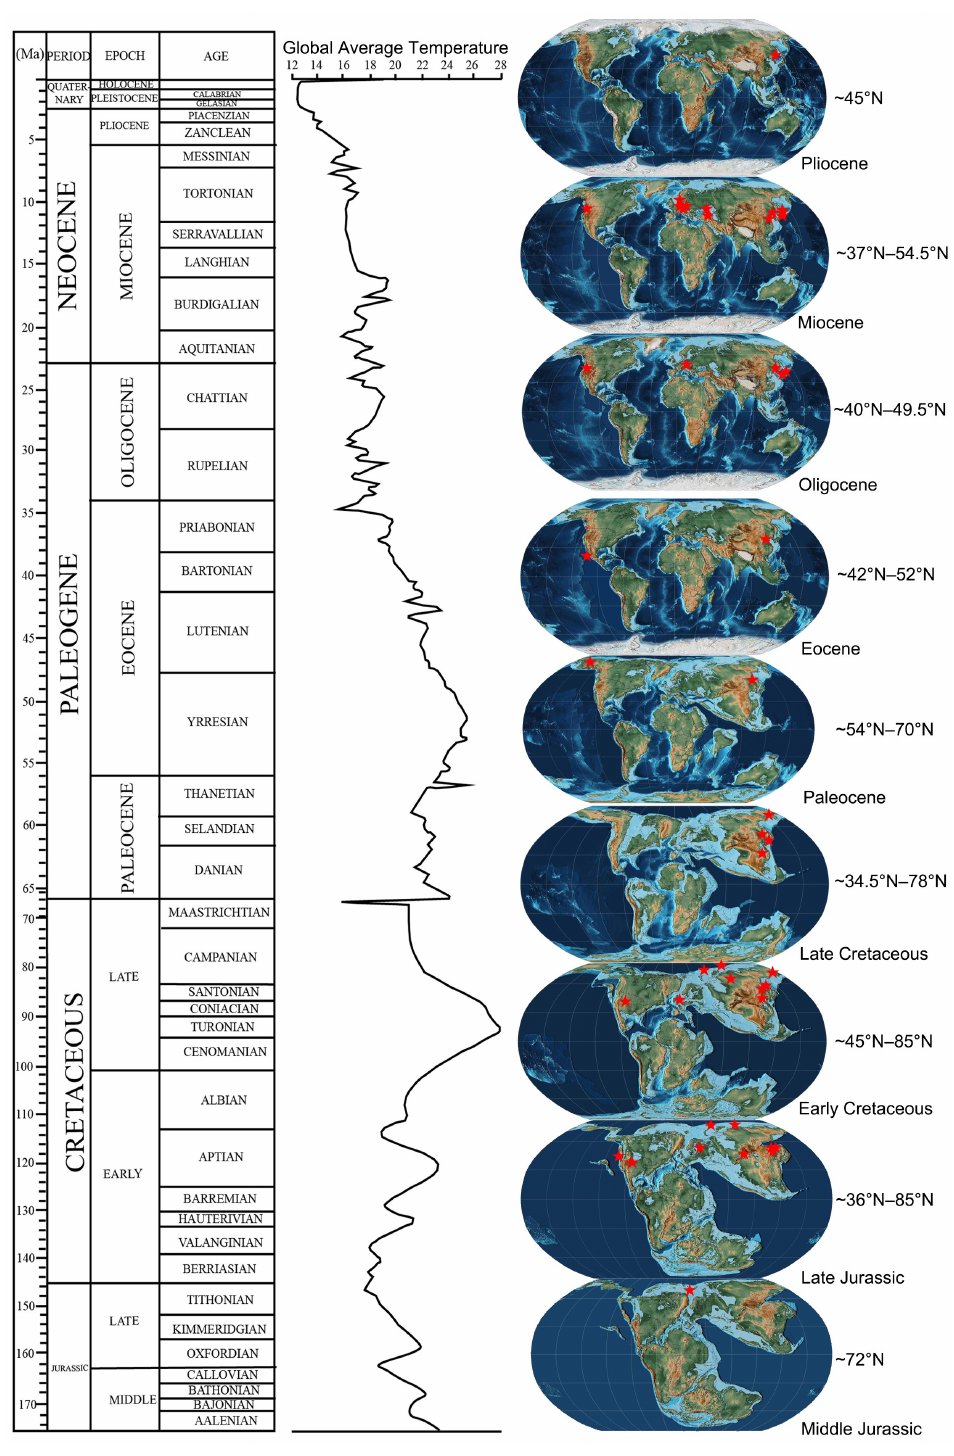
Figure 6. Geographical and geological distribution of Keteleeria -like fossils (red stars) in the world (global average temperature data from